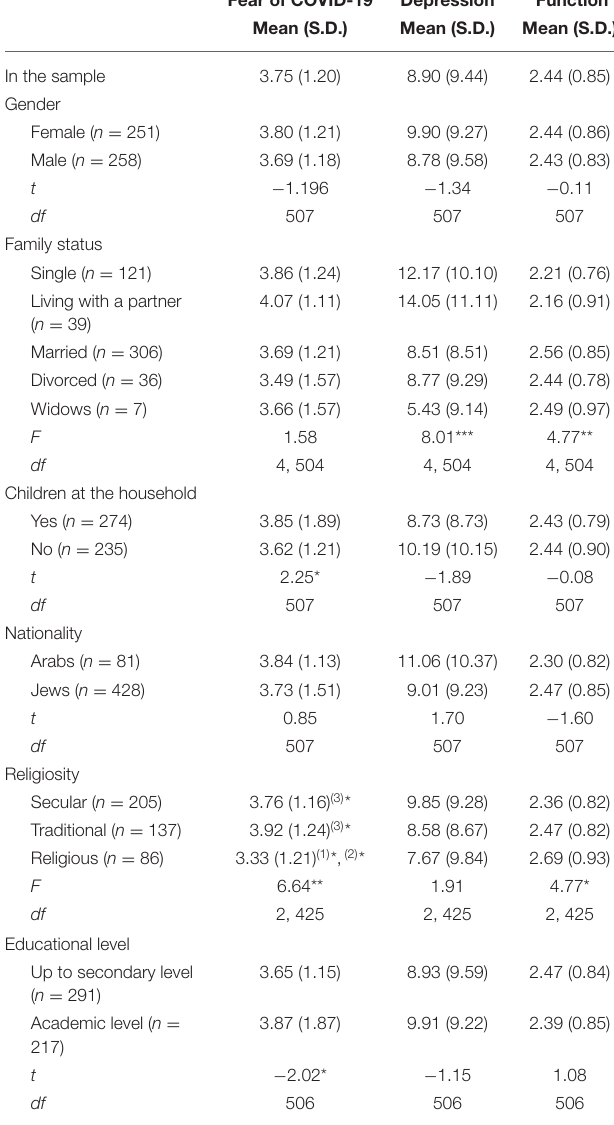
TABLE 3 | Association between demographic characteristics, function (POAMS-TV) and depression ( N = 509). Fear of COVID-19